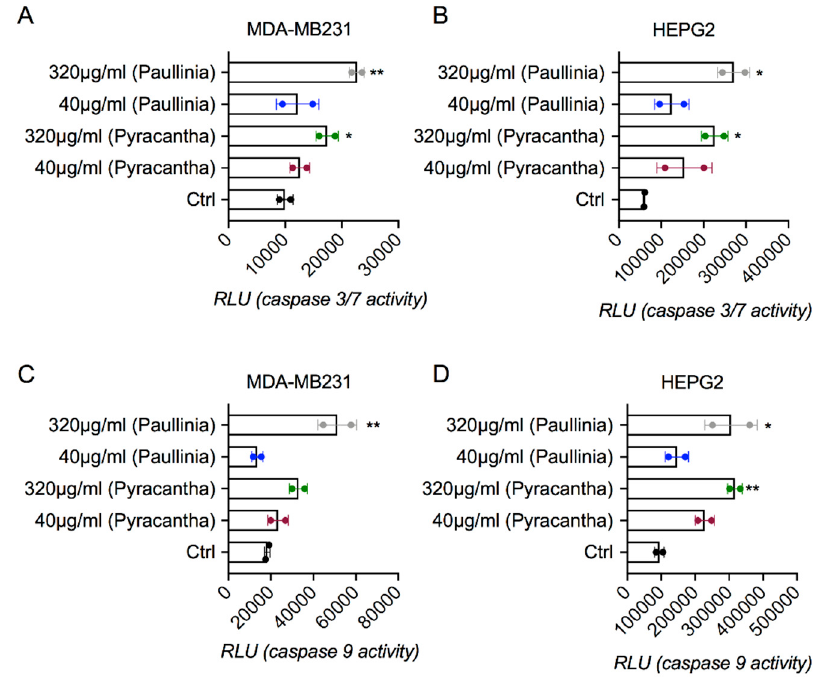
Figure 7. Pyracantha and Paullinia induce apoptosis in cancer cells. ( A and B ) Caspase-3/7 activity was measured in MDA-MB231 and HEPG2 cells treated with two different concentrations (40 or 320 µg.ml –1 ) of Pyracantha and Paullinia extracts, respectively. ( C and D ) Caspase-9 activity was measured in MDA-MB231 and HEPG2 cells treated with two different concentrations (40 or 320 µg.ml –1 ) of Pyracantha and Paullinia extracts, respectively.* p < 0.05; ** p < 0.01. Untreated samples were used as controls for all tested plant extracts.